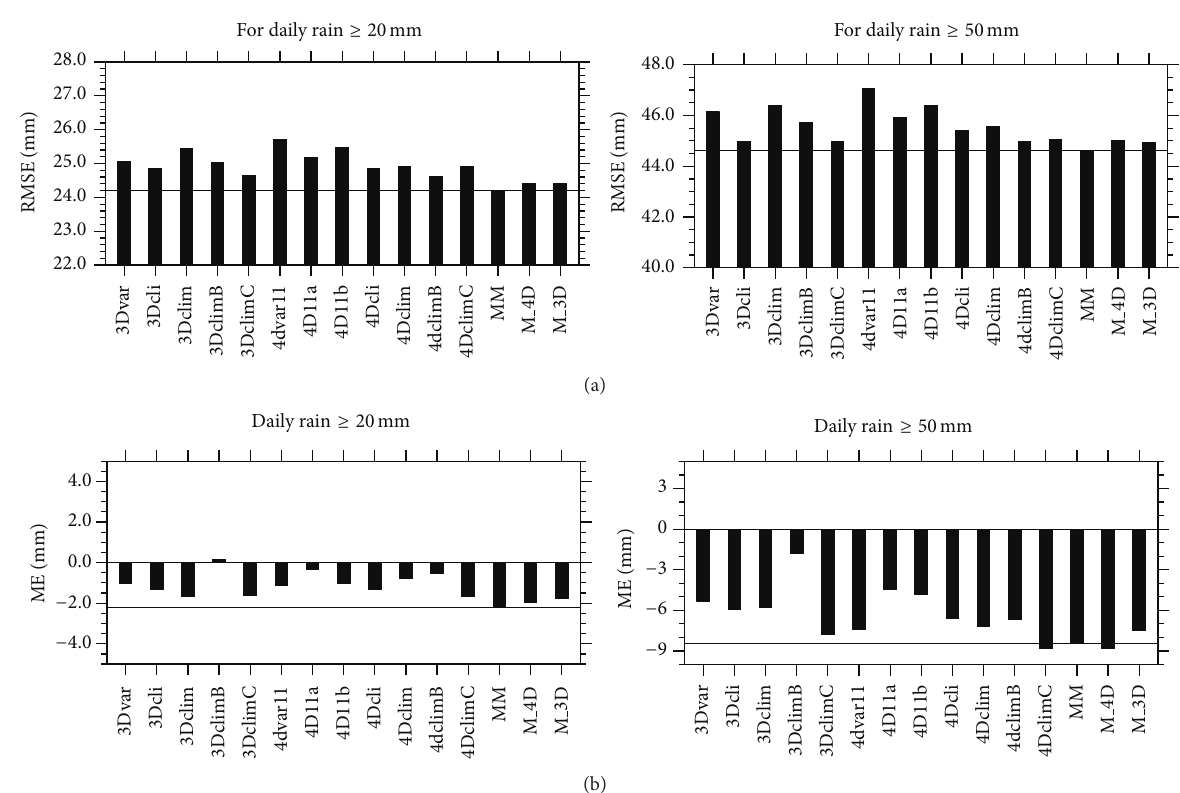
Figure 8: Root mean square errors (RMSE, (a)) and mean errors (ME, (b)) of daily rainfall at 630 stations for all simulations. Refer to Table 1 for the meaning of each member. MM denotes the ensemble mean of the 12 members. M 4D and M 3D denote the ensemble mean of the seven 4Dvar members and the five 3Dvar members, respectively. The solid line denotes the value of MM, the same hereafter.